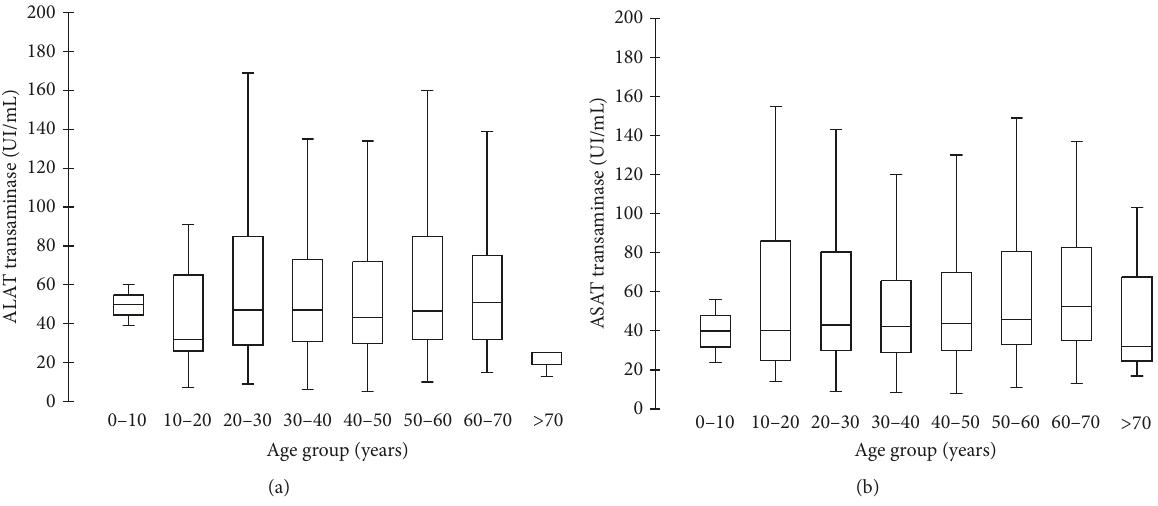
Figure 5: ASAT (a) and ALAT (b) concentrations according to 10-year classes of age of